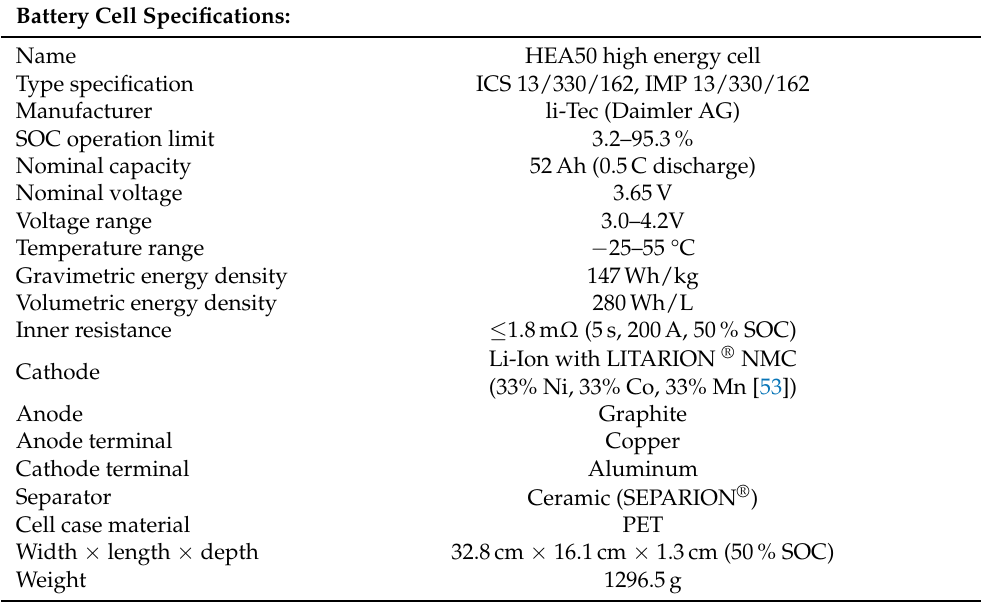
Table 3. Specifications of battery cell HEA50 high energy cell (ICS 13/330/162, IMP 13/330/162) of Smart e.d. (3rd Generation)